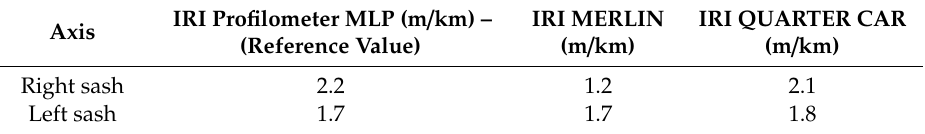
Table 4. International roughness index (IRI) results obtained according to proposed methods.